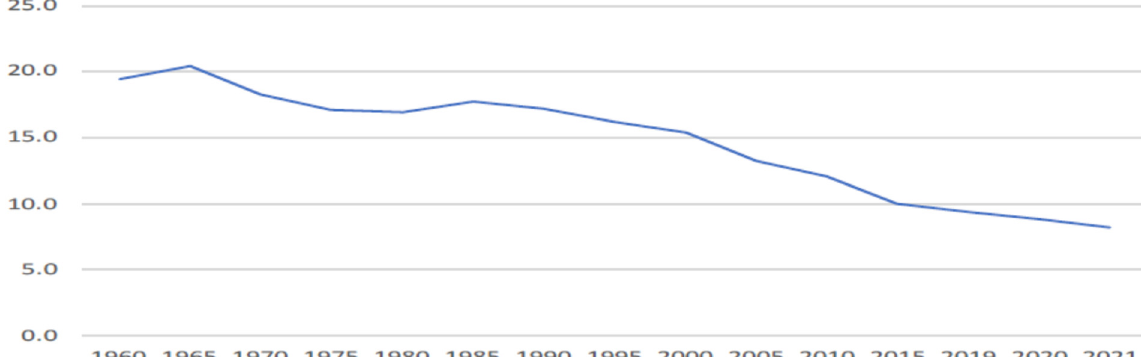
Figure 13. Geographic Mobility Rates (% of population). Source: Current Population Survey.